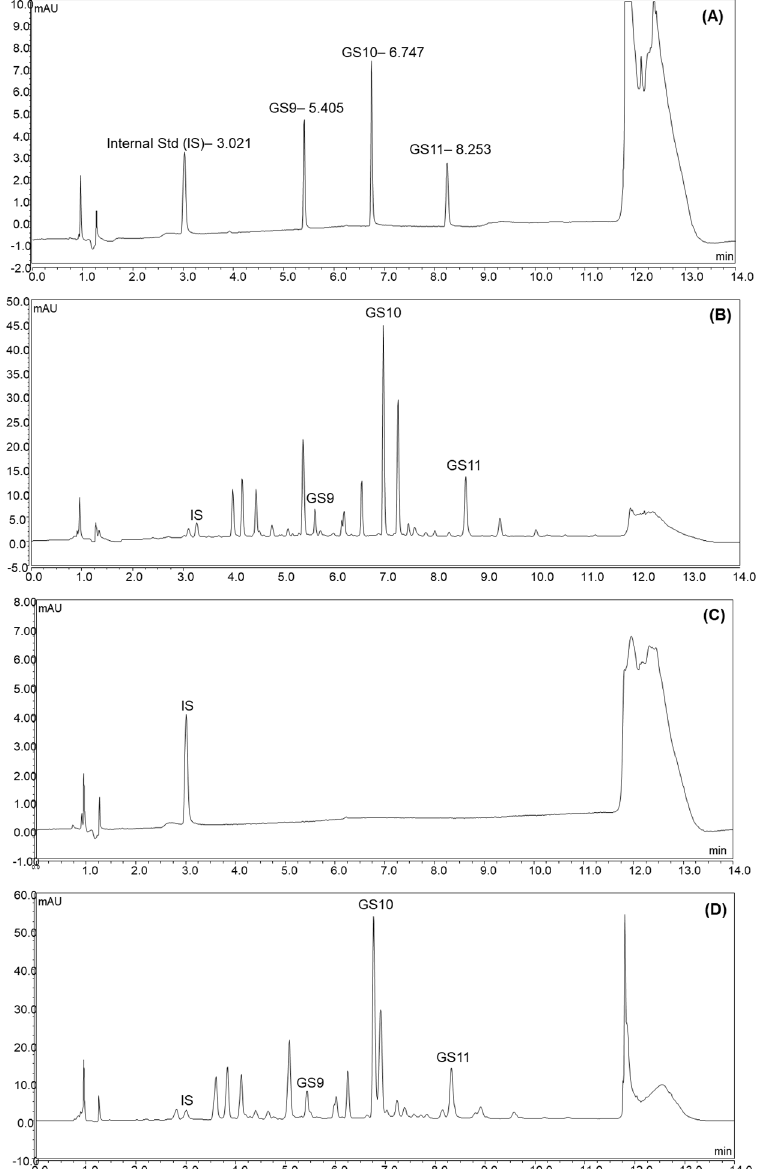
Figure 2. The chromatograms of reference standard mixture of GS9, GS10, GS11, and IS ( A ); extracts of camelina seed ( B ); camelina oil ( C ); camelina defatted meal ( D ) spiked with IS.